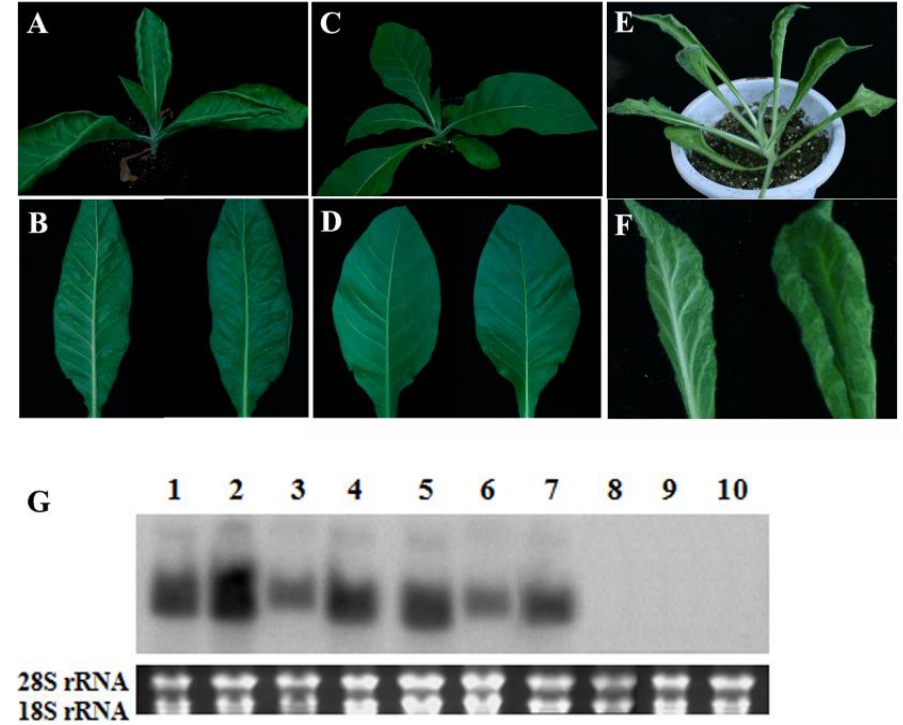
Figure 2. Phenotypes and Northern blot analysis of transgenic plants containing the TYLCCNB β C1 gene. Phenotypes of transgenic tobacco transformed with 35S-Y25 β C1, symptomatic plants ( A and B ); symptomless ( C and D ); 35S-Y10 β C1 ( E and F ); ( G ) Northern blot analysis. Lanes 1–4, 35S-Y10 β C1; lanes 5–7, 35S-Y25 β C1 (symptomatic plants); lanes 8,9, 35S-Y25 β C1 (symptomless plants); lane 10, pCHF3 empty vector. The ethidium bromide-stained gel shown below the blot indicates equal loading of total